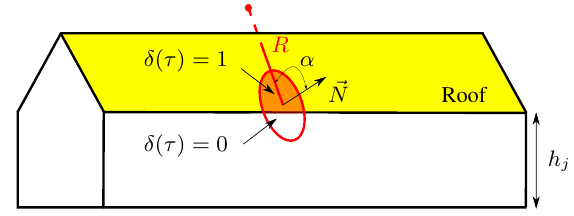
Figure 5: Illustration of the iterative segment adjustment algo- rithm.